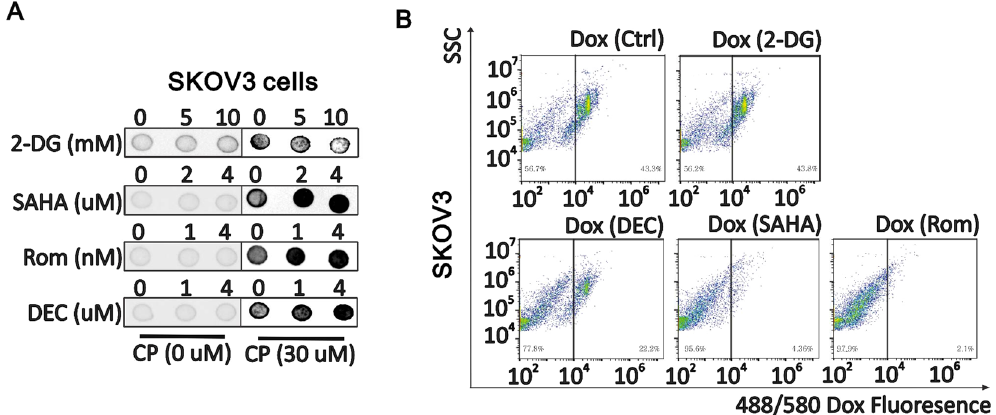
Figure 4. ETD increases DTD accessibilities in chromosome. ( A ) Dot blot analysis of CP-DNA adduct when SKOV3 cells were treated with 2-DG, SAHA, Rom or DEC with indicated concentration for 6 h, or SKOV3 cells were treated with a combination of CP 30 uM 4 h and 2-DG, SAHA, Rom or Dec with indicated concentration for another 6 h. ( B ) Flow cytometer detection of DOX autofluorescence in nuclei from cells treated with Dox alone or combined with 2-DG, DEC, SAHA or Rom. X axis indicates the 488/580 Dox fluorescence value, Y axis indicates